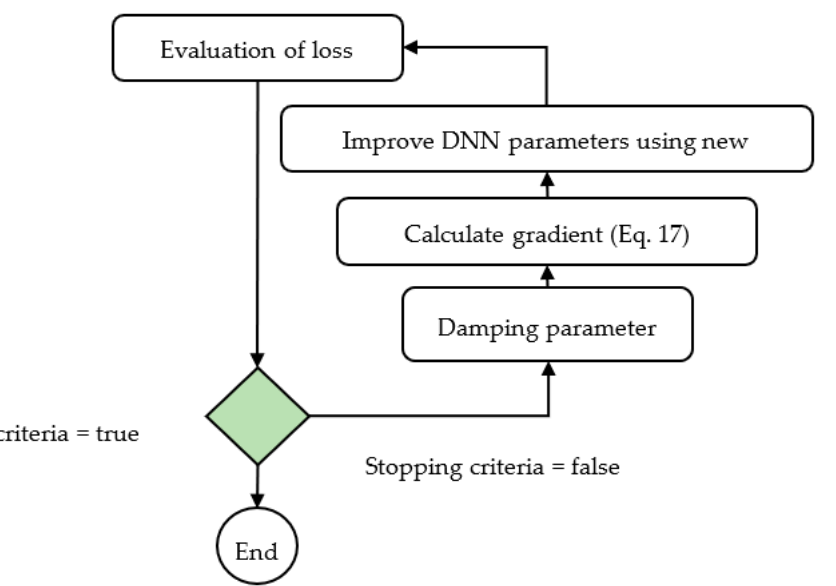
Figure 7. ( a ) Back propagation algorithm of DNN, ( b ) Graphic representation of DNN.